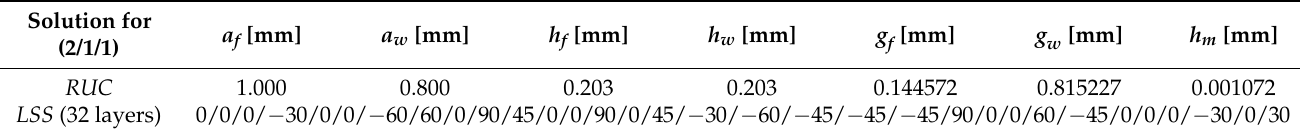
Table 4. The best solution found when using satin 2/1/1 fabric as reinforcement.